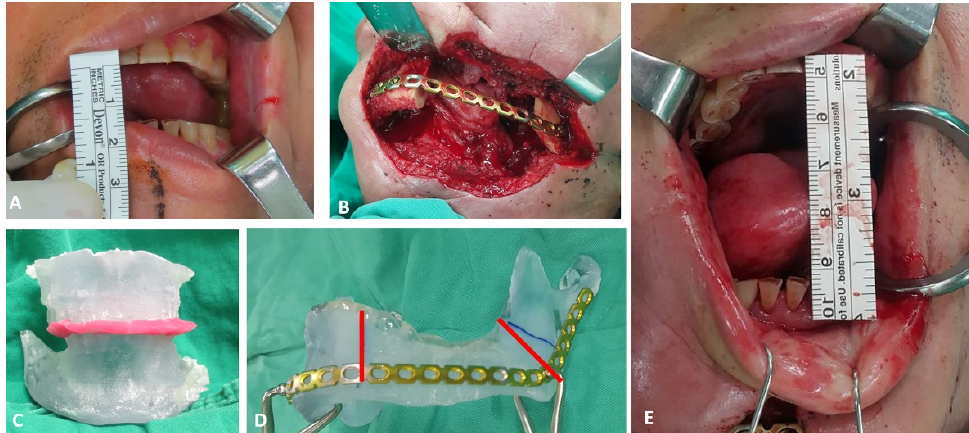
Figure 7. Pre-bent individualized plates adaptation in dentulous patients. ( A , E ) Mouth opening before and after coronoidectomy and contracture release. ( B , C ) Pre-bent reconstruction plate fixed to the residual mandibular segments with the guidance of occlusal splint and marked holes. ( D ) Marking of resection margins on the model as per intraoperative scenario, taking linear measurements from mandibular angle or mandibular notch as a reference. (Red line).